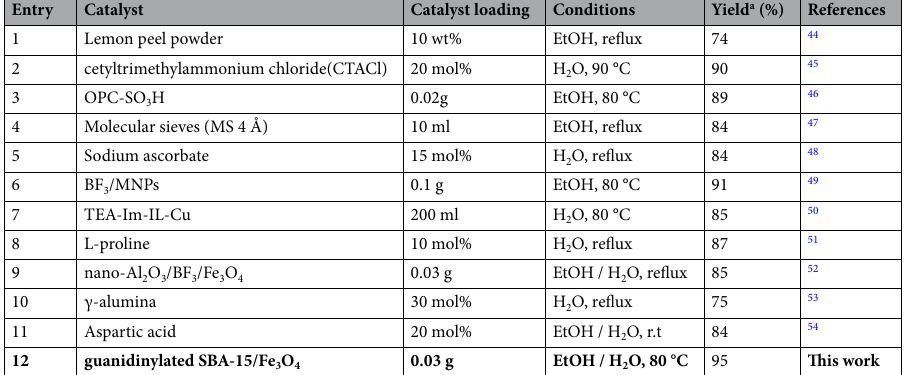
Table 4. Comparison of the catalytic performance of the guanidinylated SBA-15/Fe 3 O 4 with some other reported catalysts for the synthesis of dihydropyrano[2,3-c]pyrazole (product 5e ). a The yields relate to the isolated product.